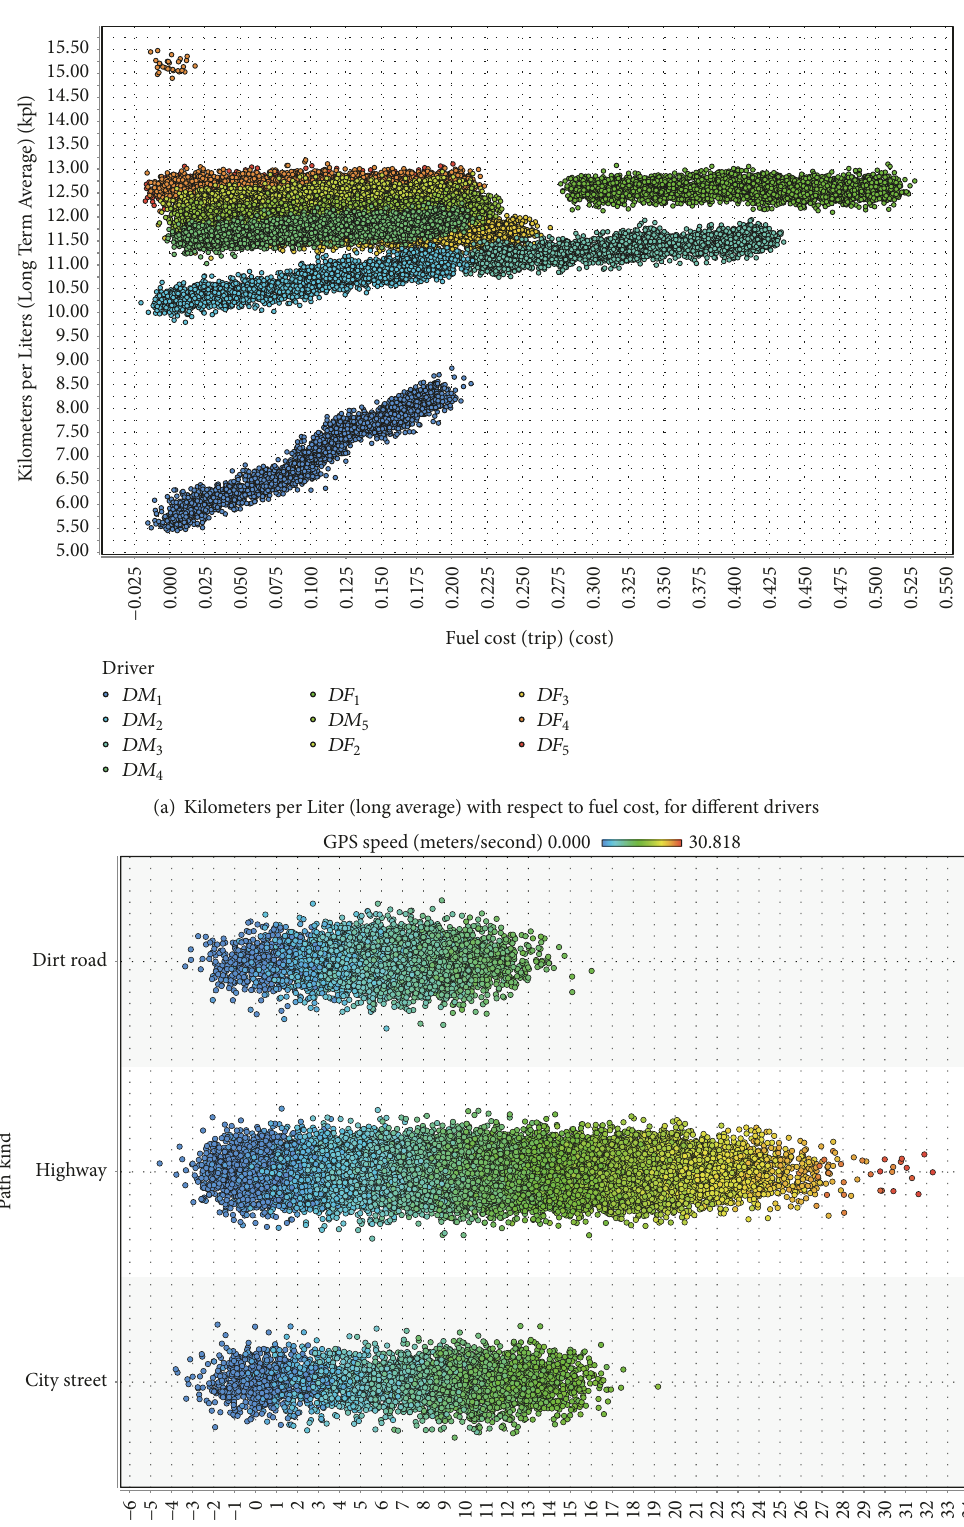
Figure 4: Scatter plots of the data distribution on dataset 𝐷 𝐴